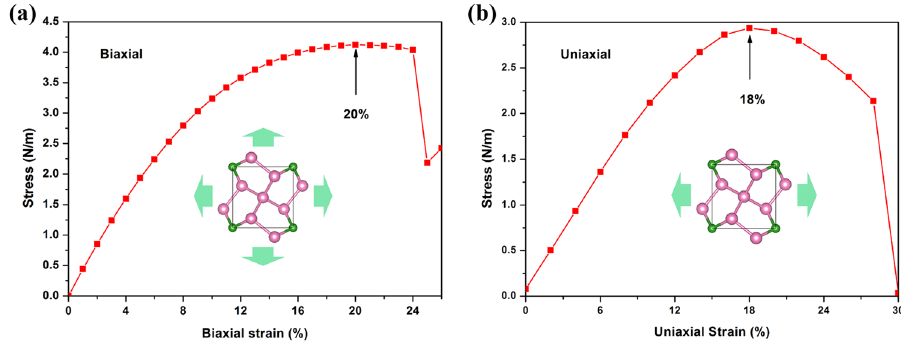
Figure 4. Stress in the penta-BP 5 monolayer subjected to ( a ) biaxial and ( b ) uniaxial